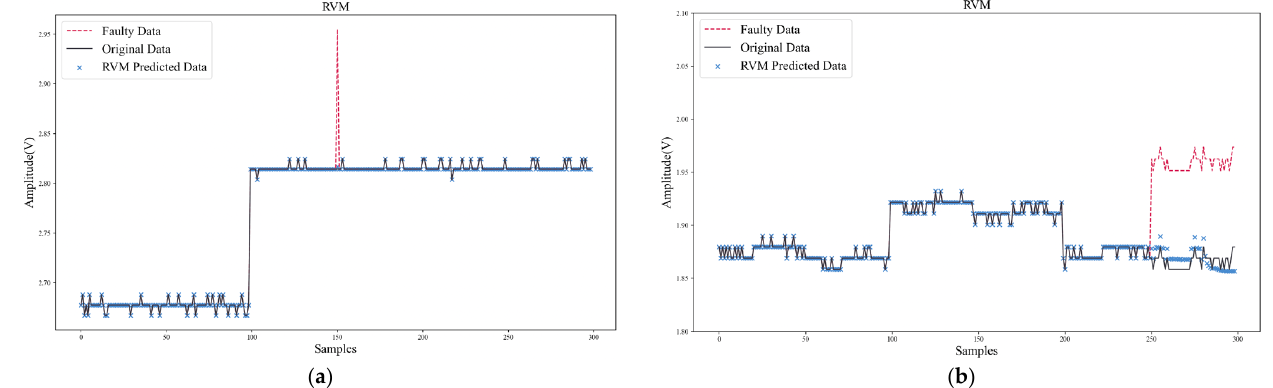
20 of 27 Table 8. Data Recovery Error (MAE/MAPE) of Different Reconstruction Methods. Figure